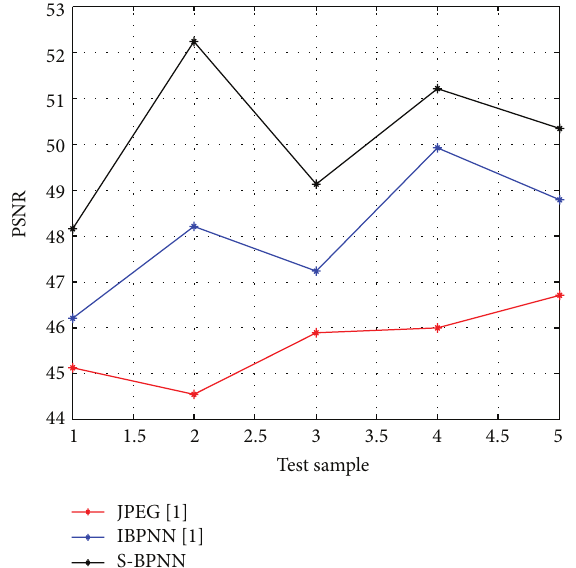
Figure 6: Comparison of PSNR in dB when the three methods are applied.